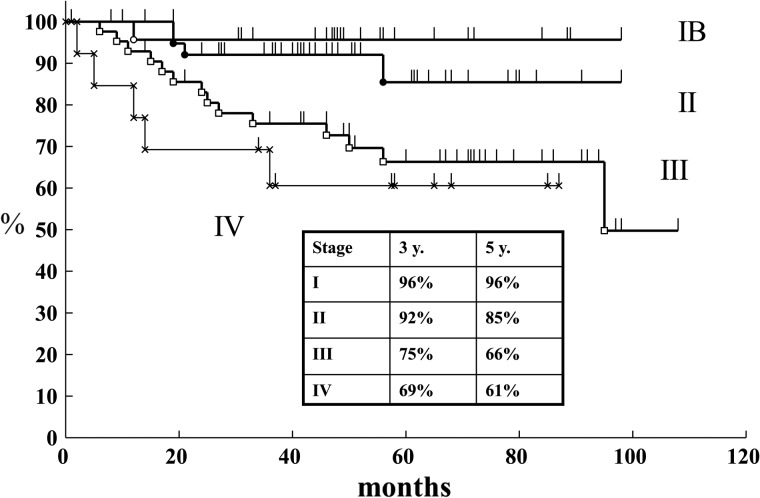
Cause-specific survival of carcinoma of the uterine cervix by stage (Arm B: February 2004–December 2009).